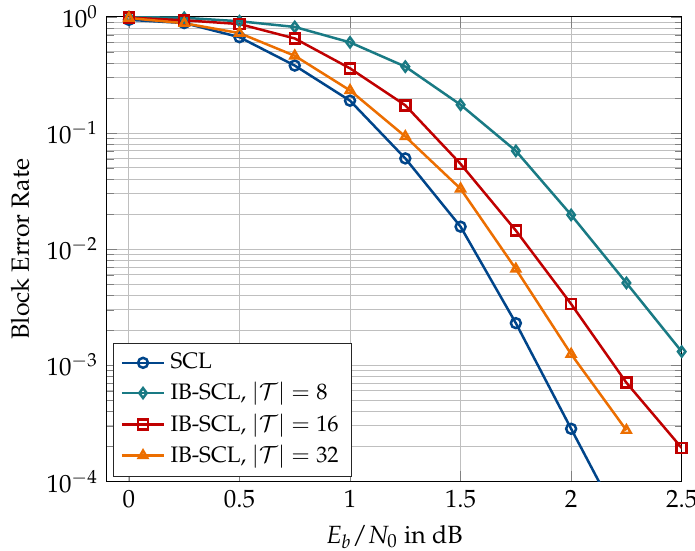
Figure 17. Block error rate comparison between conventional decoder (SCL) and information bottleneck decoders (IB-SCL) constructed for |T | = 8,16 or 32. N = 1024, N L = 32, 16-bit CRC, code rate 0.5, and design E b / N 0 = 3 dB.